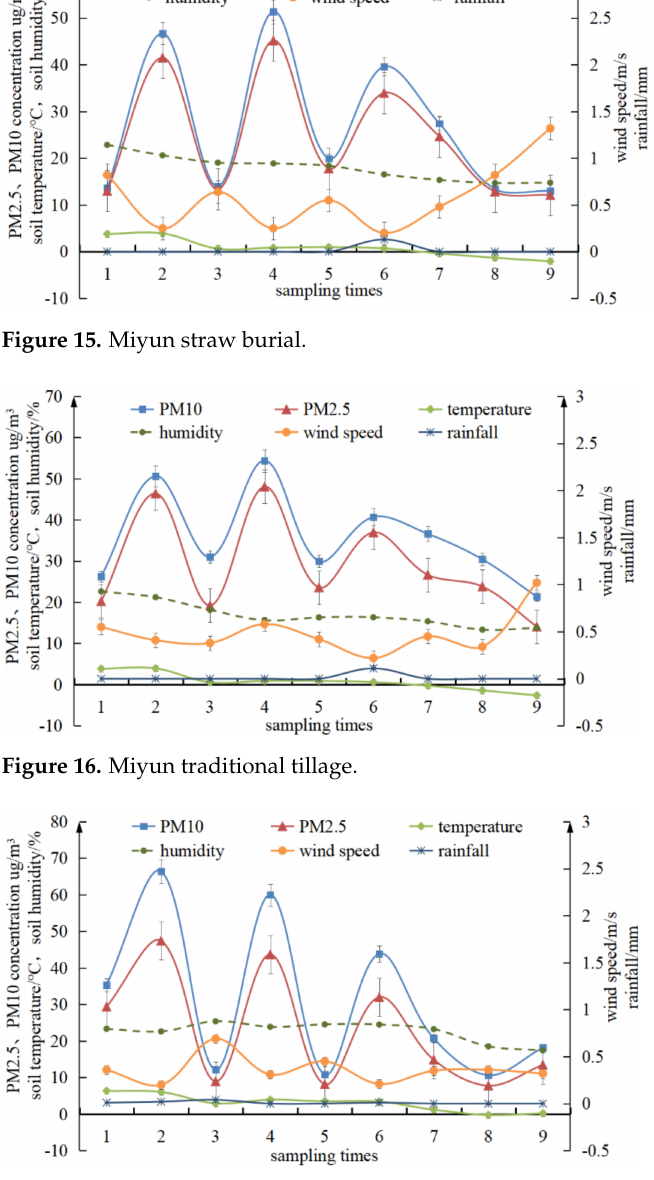
Figure 17. Huairou stubble + straw